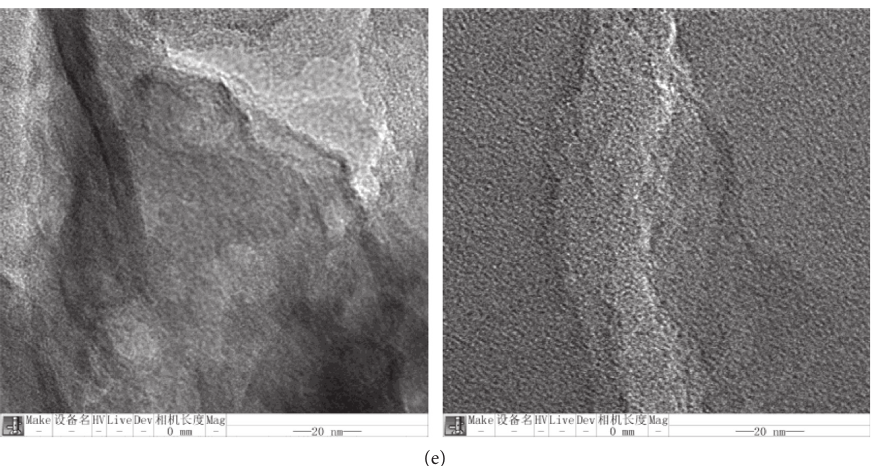
Figure 13: Microstructure and morphology of coal after loading. (a) 500nm. (b) 200nm. (c) 100nm. (d) 50nm. (e)